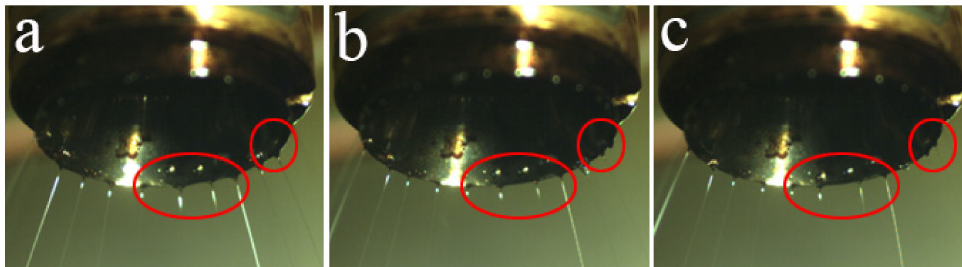
Figure 10. Photos of local jet distribution at di ff erent times when the spinning voltage is 20 kV: